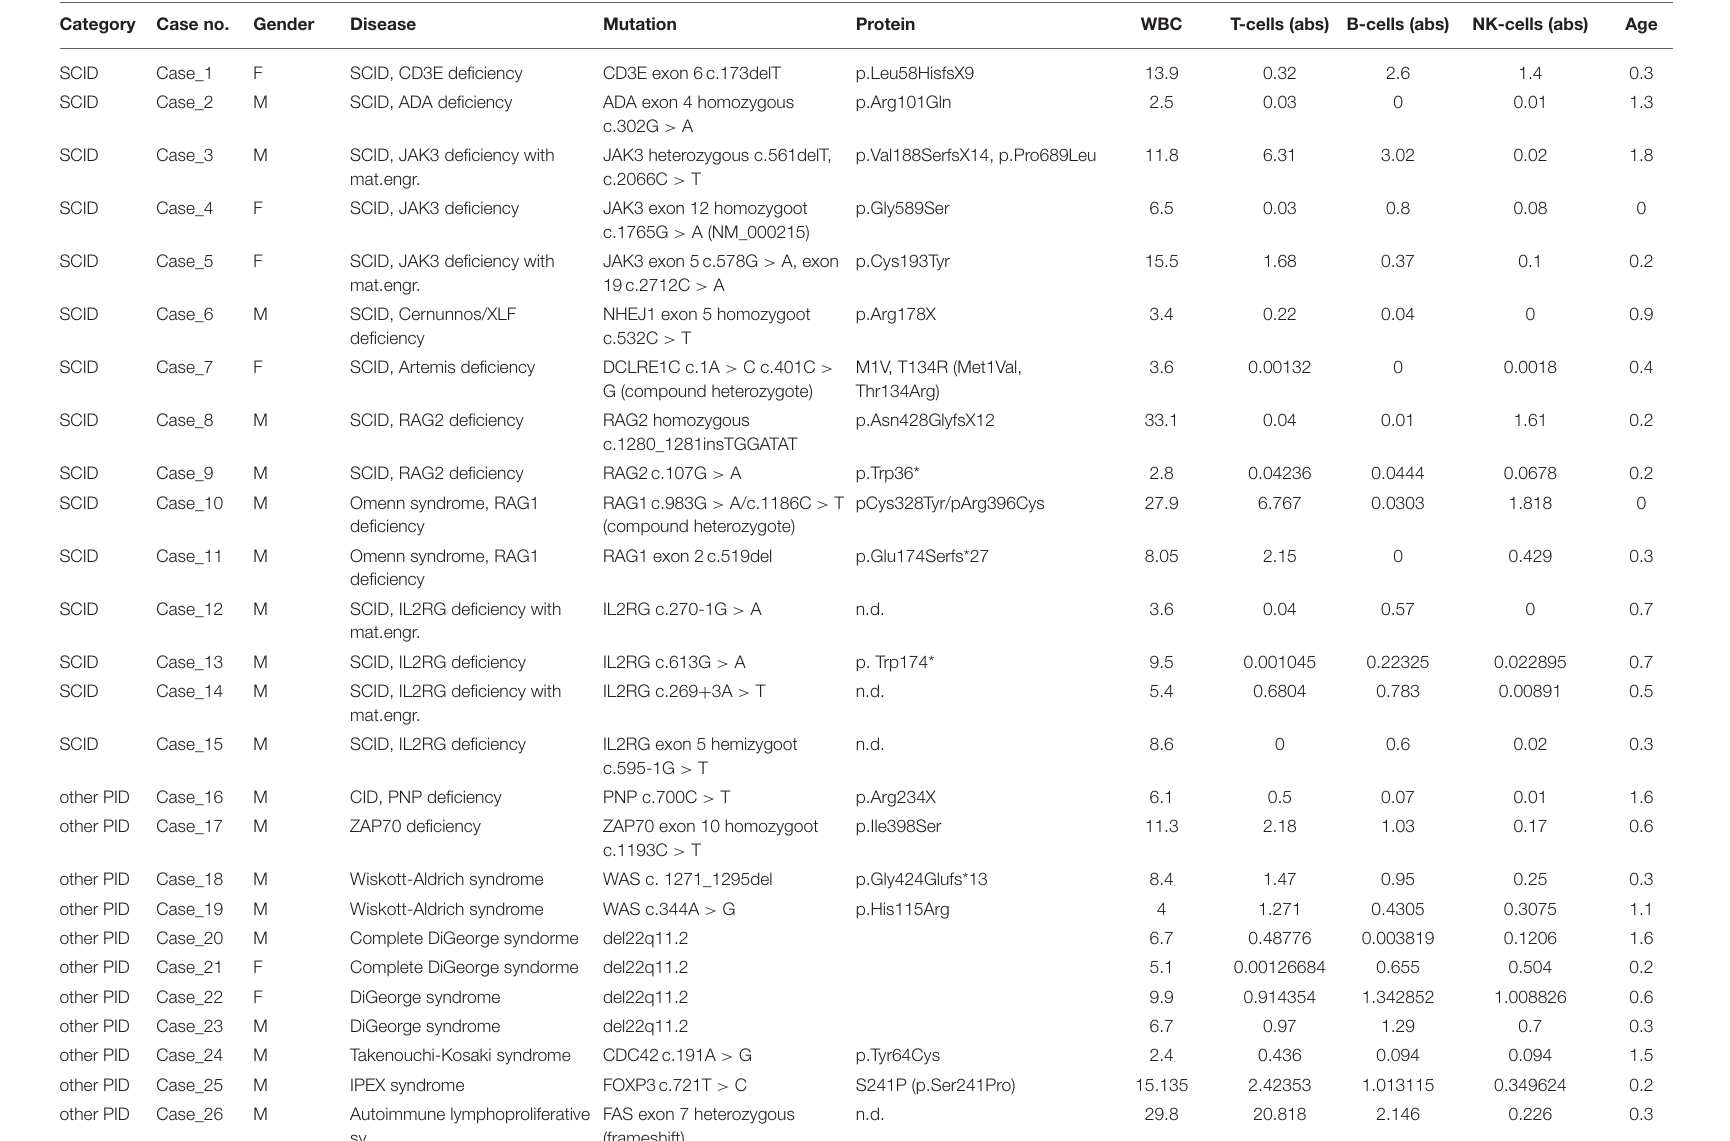
TABLE 1 | Characteristics of patients, WBC and lymphocytes subsets (TBNK) reported by the referring clinician (x 10e3/ µ l). Category Case no.